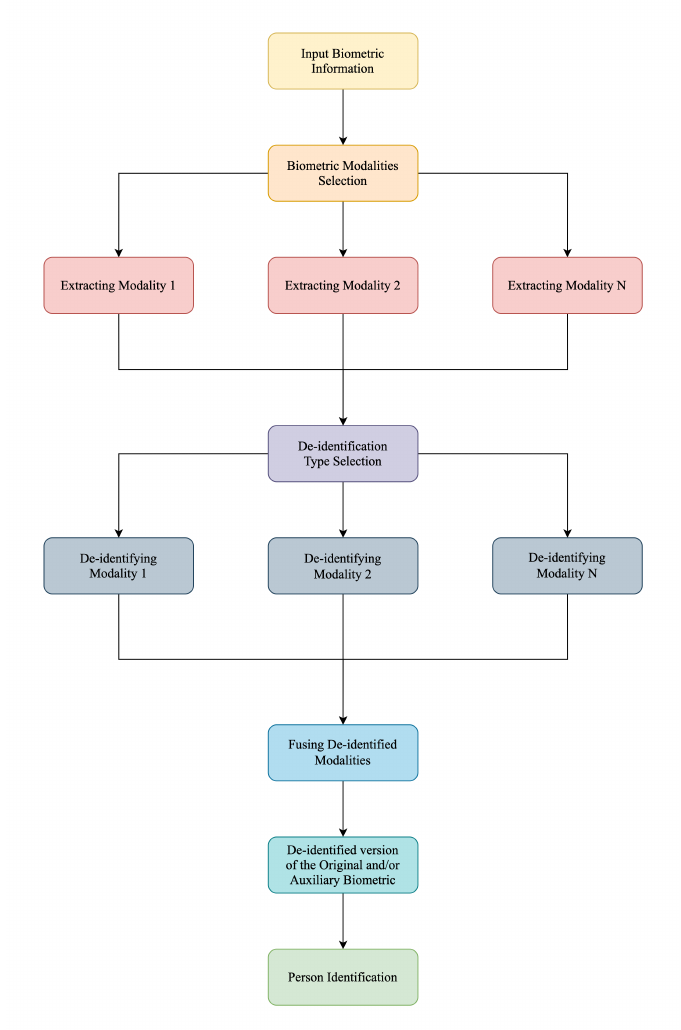
Figure 3. Flowchart of the multi-modal de-identification